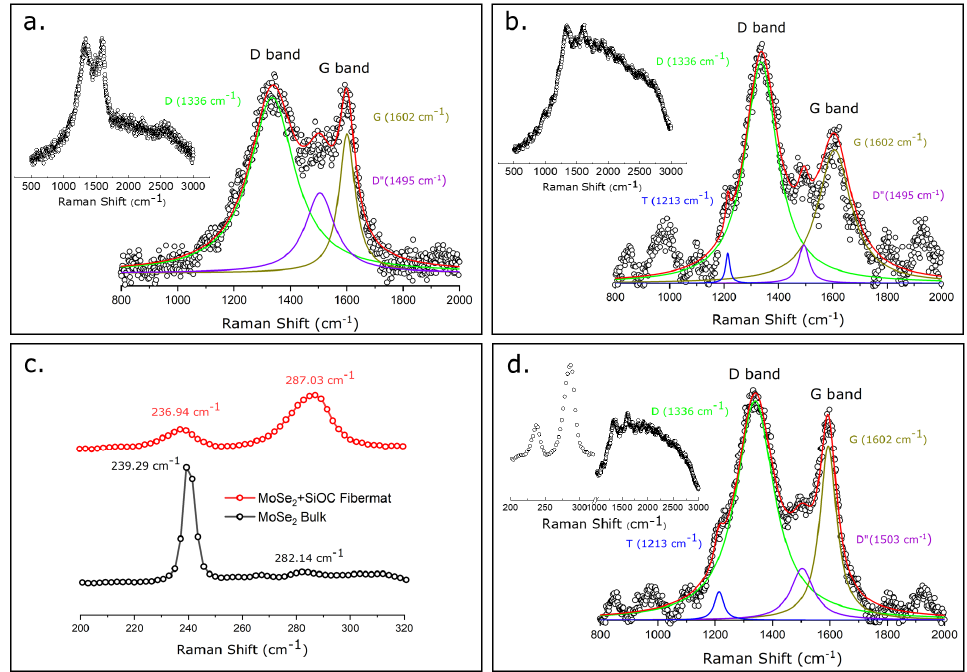
Figure 4. ( a ) Raman spectra of carbonized PVP fiber mat with integrated peaks; ( b ) Raman spectra of pyrolyzed PVP/SiOC fiber mat with integrated peaks; ( c ) Raman spectra of bulk MoSe 2 powder and the region of 200–300 cm − 1 from the pyrolyzed SiOC/MoSe 2 fiber mat; ( d ) Raman Spectra of pyrolyzed PVP/SiOC/MoSe 2 fiber mat with integrated peaks in the region of 800–2000 cm − 1 . Figure 5 illustrates the XPS survey scan of the carbonized/pyrolyzed PVP, PVP/SiOC, and PVP/SiOC/MoSe 2 fiber mats. C 1s, O 1s, and N 1s peaks were visible in the survey scan of the carbonized PVP fiber mat, which validated the presence of these molecules, even after the pyrolysis stage. The survey scan of the pyrolyzed PVP/SiOC fiber mat revealed the presence of Si 2p, O 1s, and C 1s. For the pyrolyzed PVP/SiOC/MoSe 2 fiber mat, two additional peaks, Mo 3d and Se 3d, were observed, which again substantiates the presence of MoSe 2 in the pyrolyzed fiber mat. Table 1 presents the elemental composition of the pyrolyzed fiber mats, which was determined by integrating the area under the respective elemental peaks. The PVP fiber mat showed the highest amount of carbon